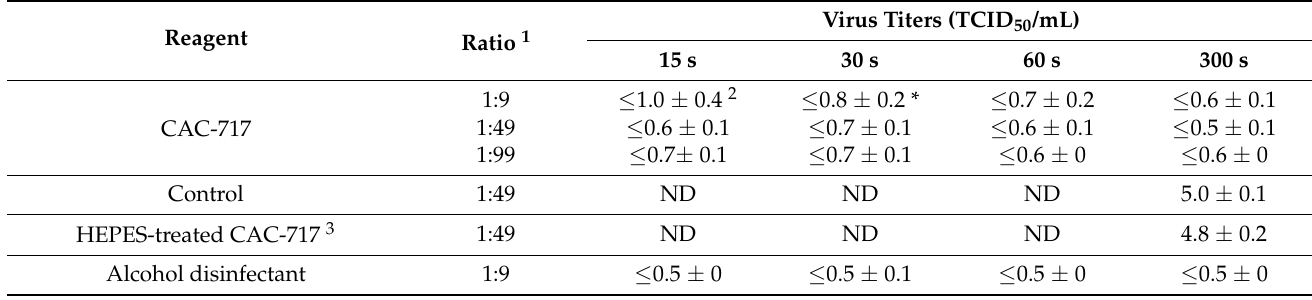
Table 1. Time- and dose-dependent effects of CAC-717 on SARS-CoV-2 viability.